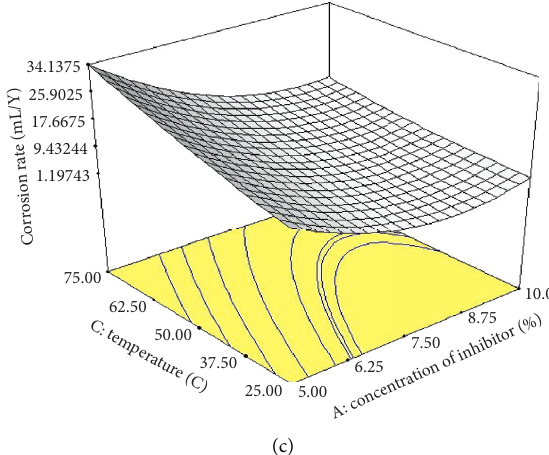
Figure 10: 3D plot of corrosion rate as a purpose of inhibitor load and temperature at rotation speeds (a) 250rpm, (b) 200rpm, and (c)